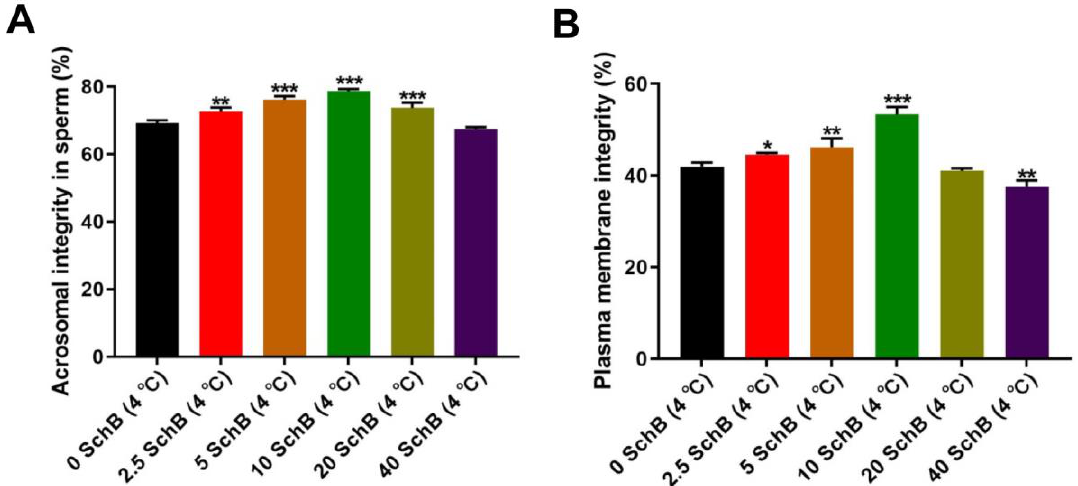
Figure 2. ( A , B ): Effects of SchB on the plasma membrane integrity and acrosome integrity of boar sperm: ( A ) Sperm motility. ( B ) abnormal sperm morphology. Data are expressed as mean ± SD ( n = 12). *** p < 0.001, ** p < 0.01 and * p < 0.05 vs. 0 Sch B.